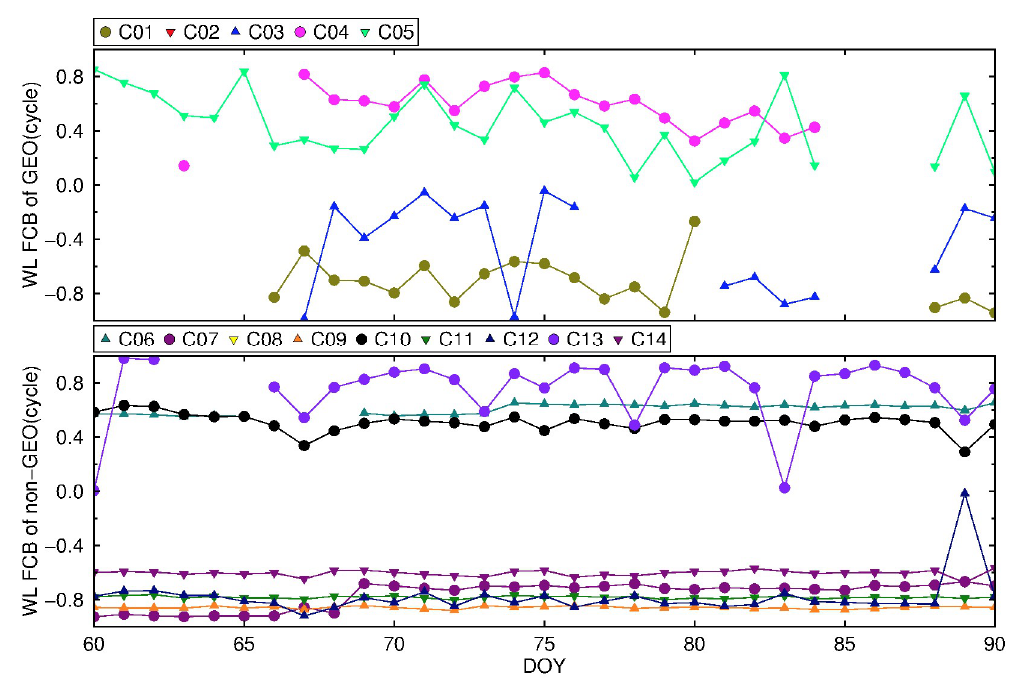
Figure 9. The variation of BDS WL FCB by the traditional strategy from DOY 061 to 090, 2018.